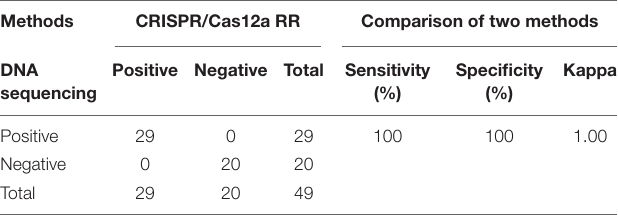
TABLE 1 | Performance comparison between CRISPR/Cas12a RR and DNA sequencing for streptomycin (STR)-resistant (K43R) detection in clinical samples. Methods CRISPR/Cas12a RR